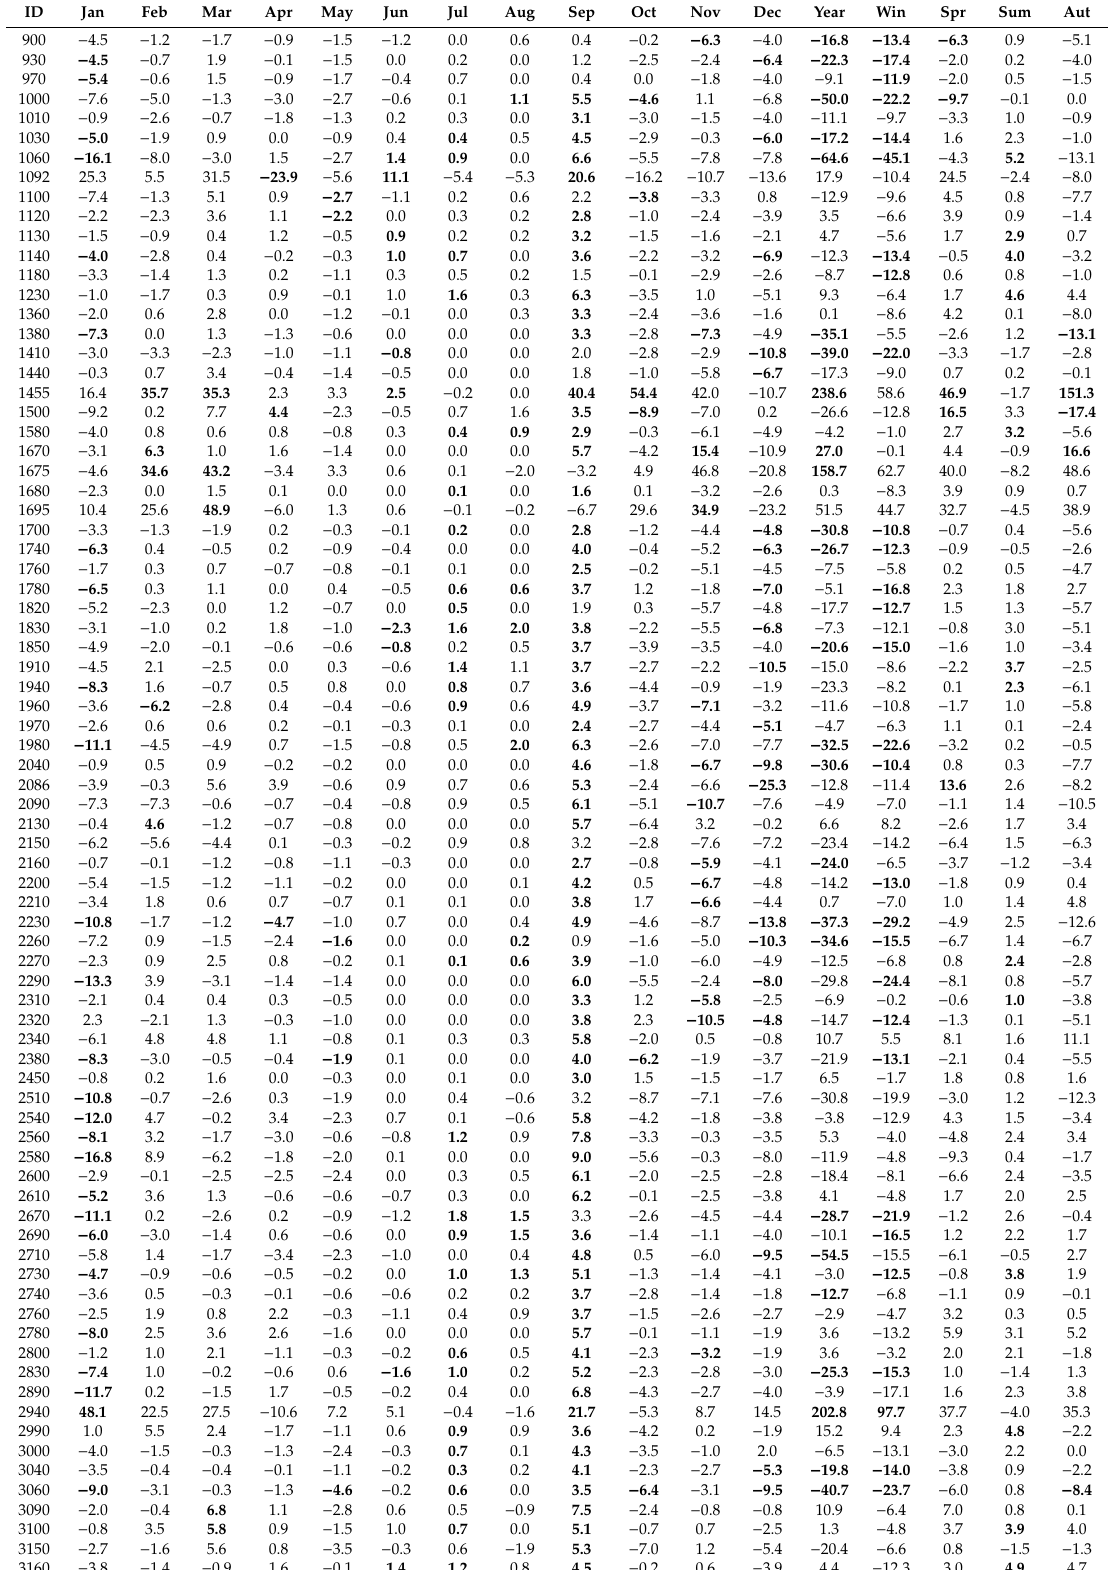
Table 1. Trend slopes (mm / 10 years) evaluated with the Theil–Sen estimator. Bold values identify significant